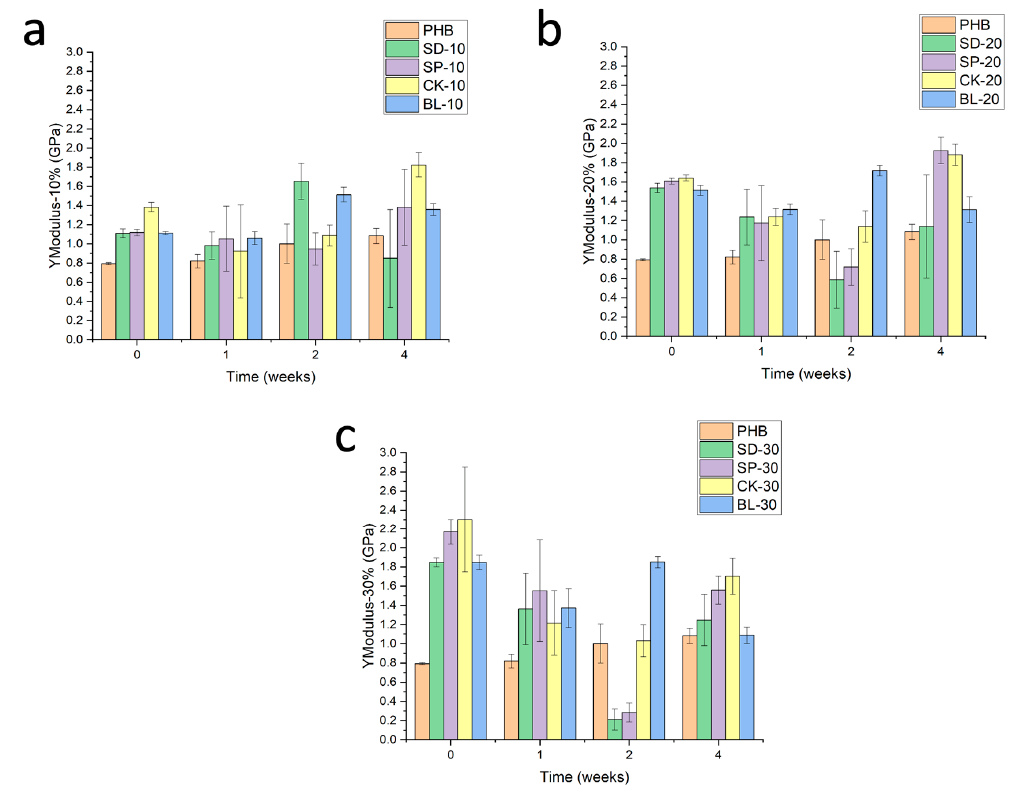
Figure 8. Evolution of the Young’s Modulus of composites with the exposure time in Xenotest chamber. Reinforcement: ( a ) 10%, ( b ) 20% and ( c ) 30%.